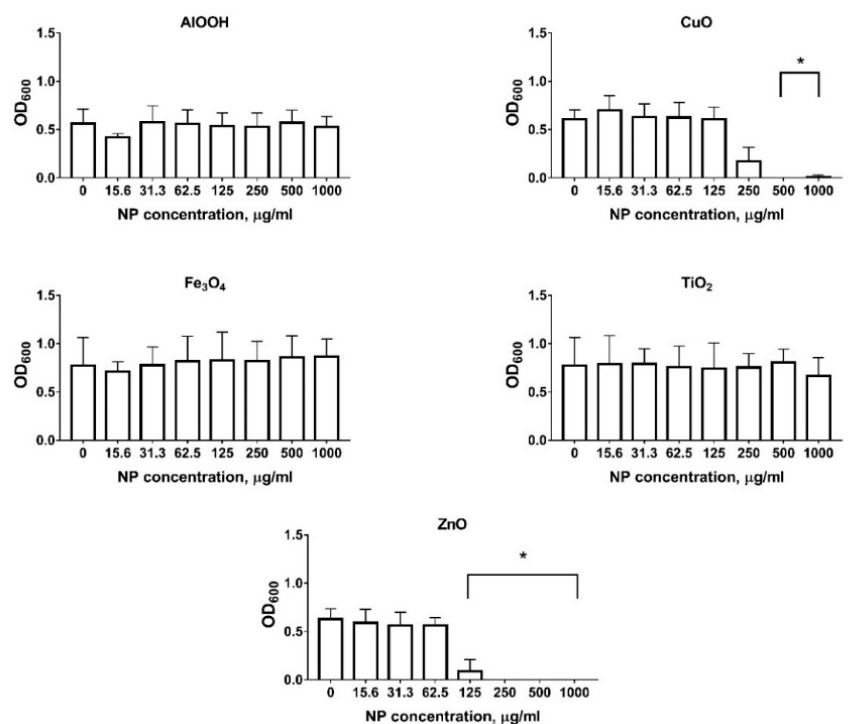
Figure 1. Metal oxide nanoparticles (MONPs) antibacterial activity against E. coli K12. The presented results are the mean of three independent experiments (three replicates in each) ± standard deviation. * p < 0.05.